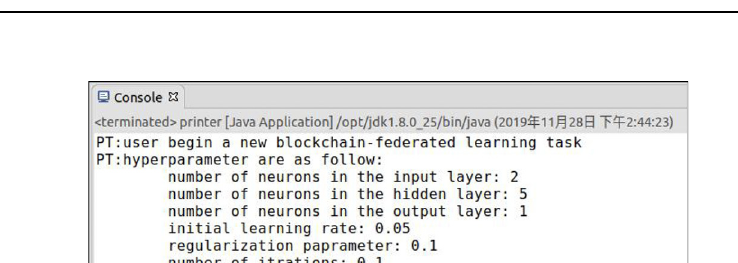
Table 1. Parameter settings in